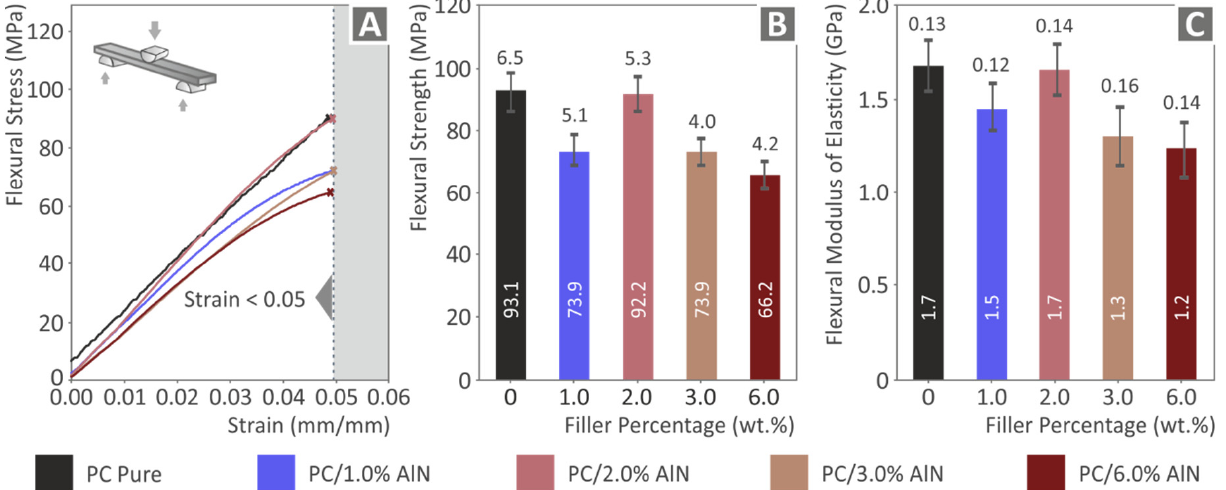
Figure 10. Flexural tests results on the 3D printed samples: ( A ) flexural stress graph as a function of strain (termination at 5% strain), ( B ) flexural strength results (average value and deviation), and ( C ) flexural modulus of elasticity results (average value and deviation) of the five tested specimens.